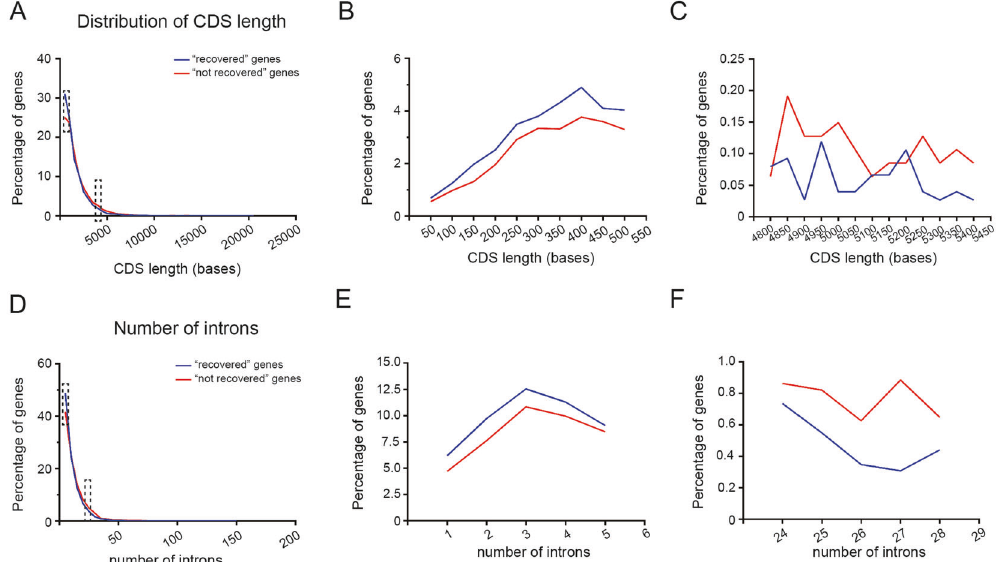
Fig. 4 Features of the “ recovered genes ” upon UV exposure. A Distribution of CDS sizes for “ recovered genes ” and “ non recovered genes ” . Each data point represents the number of CDSs in each size class in increments of 100 bp. Where there are several CDS isoforms in a gene, they are all counted. B Enlarged view of the fi rst 500 bases shown in Fig. 4A. C Enlarged view of the middle 600 bases shown in Fig. 4A. D Distribution of number of introns per gene. Each data point represents the number of genes having a speci fi c number of introns. E